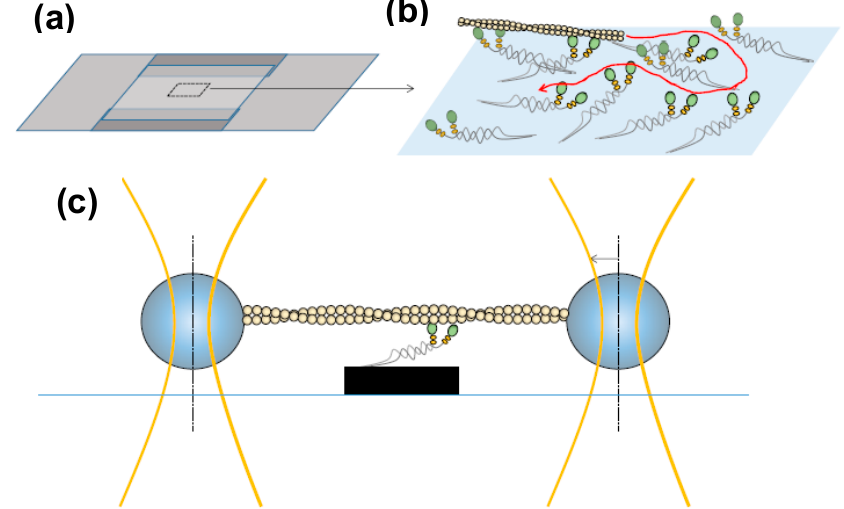
Figure 3. In vitro motility assay and optical tweezers set-up for single-molecule mechanics. ( a ) Flow cell of two cover-slips sandwiched on top of each other via spacers; ( b ) magnified view of rectangular area in ( a ) indicating the principle for the gliding in vitro motility assay with surface-adsorbed myosins that propel an actin filaments. Curved arrow (red) indicates possible filament sliding path; ( c ) schematic of the three-bead optical tweezers assay where an actin filament is suspended between two beads held in optical traps. The filament is then lowered down to allow the actin filament to interact with single myosin motor fragments adsorbed to a third bead or another type of pedestal as indicated here.